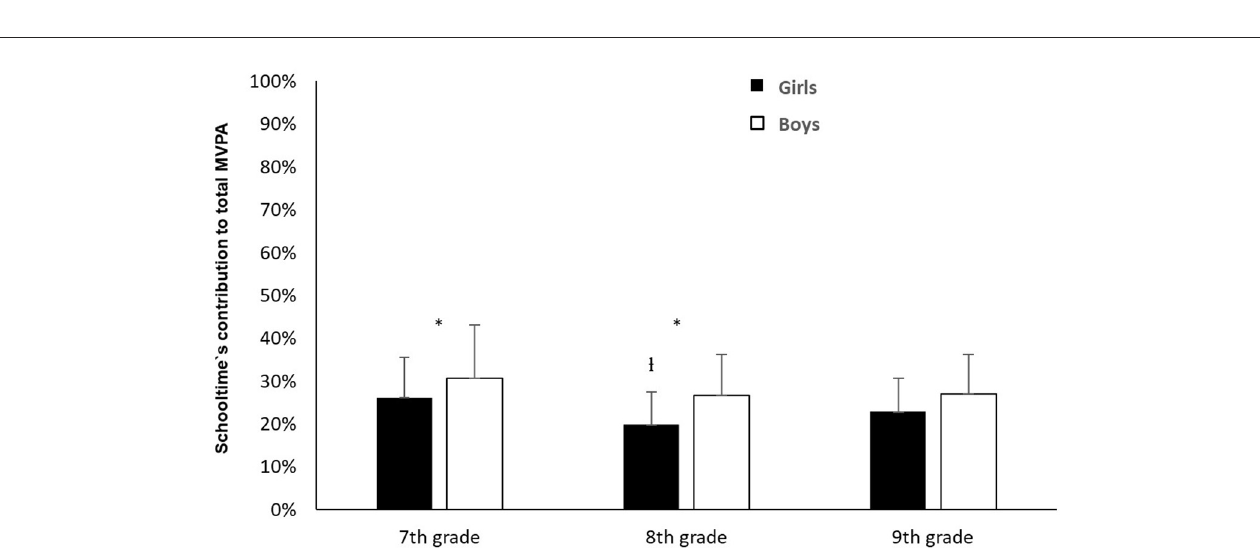
FIGURE2 Average percentage of schooltime’s weekly contribution of MVPA in relation to the pupils’ (girls/boys) total weekly MVPA. † Indicates a significant difference in schooltime’s contribution to girls’ total MVPA between 7 th and 8 th grade ( p < 0.001). *Indicates a significant difference in schooltime’s contribution of MVPA in relation to total MVPA between girls and boys ( p <